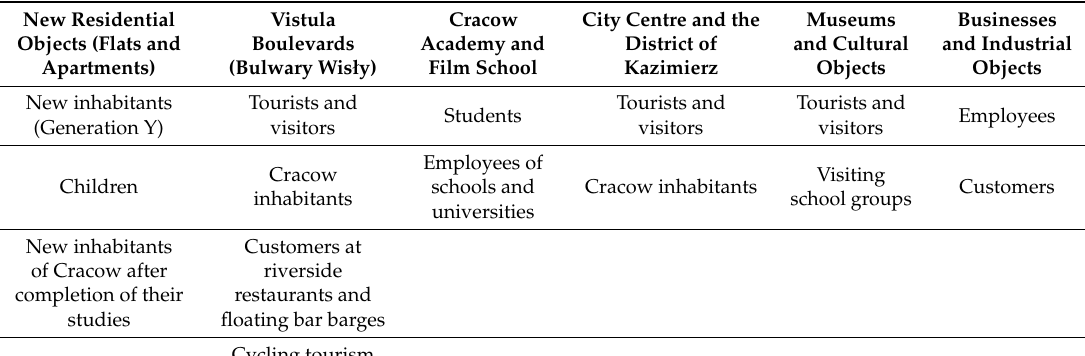
Table 2. User groups in the project-related area and their needs (table by E. Latusek). New Residential Objects (Flats